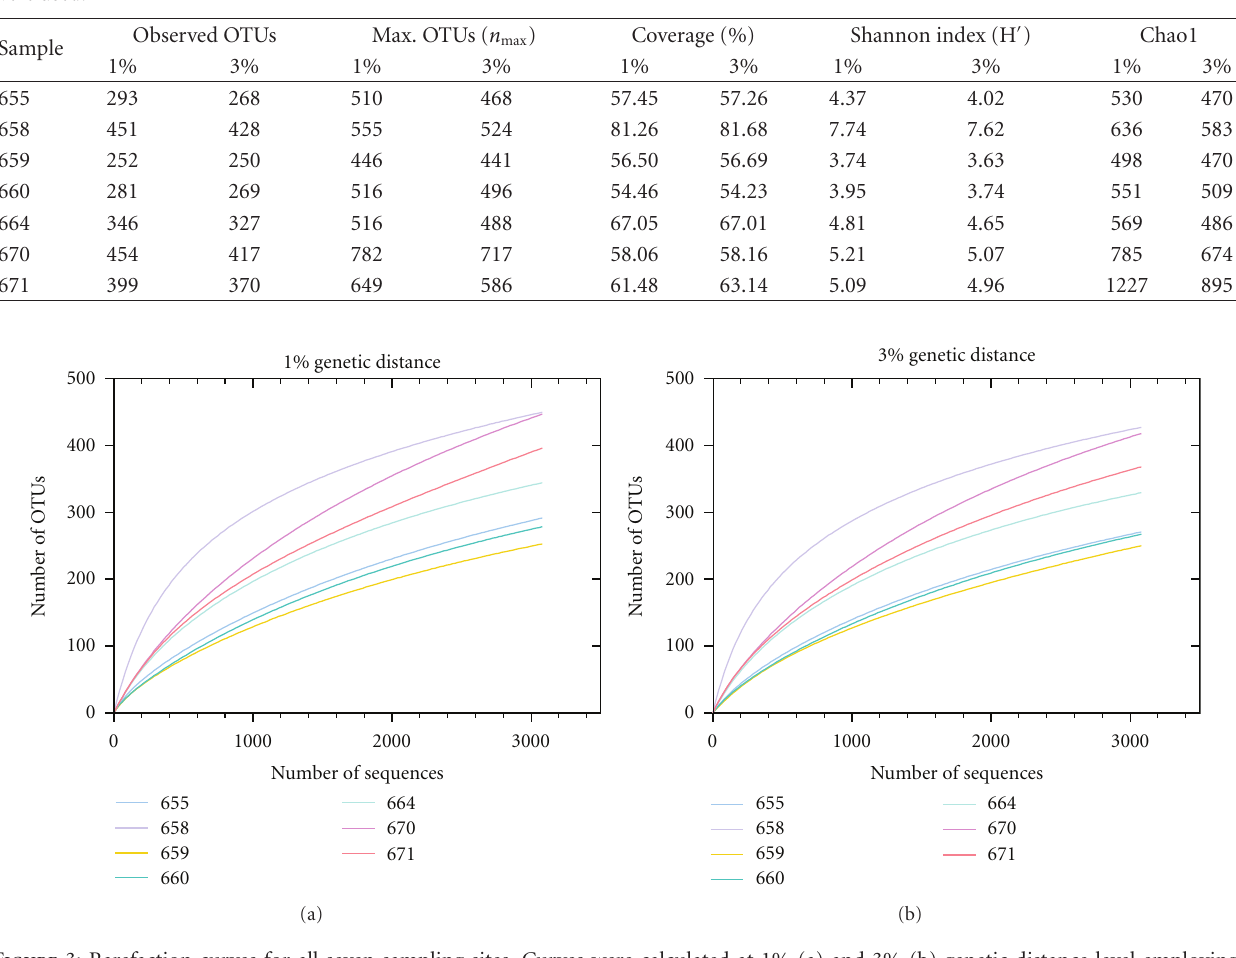
Figure 3: Rarefaction curves for all seven sampling sites. Curves were calculated at 1% (a) and 3% (b) genetic distance level employing QIIME [21]. Description of samplings sites is shown in Table